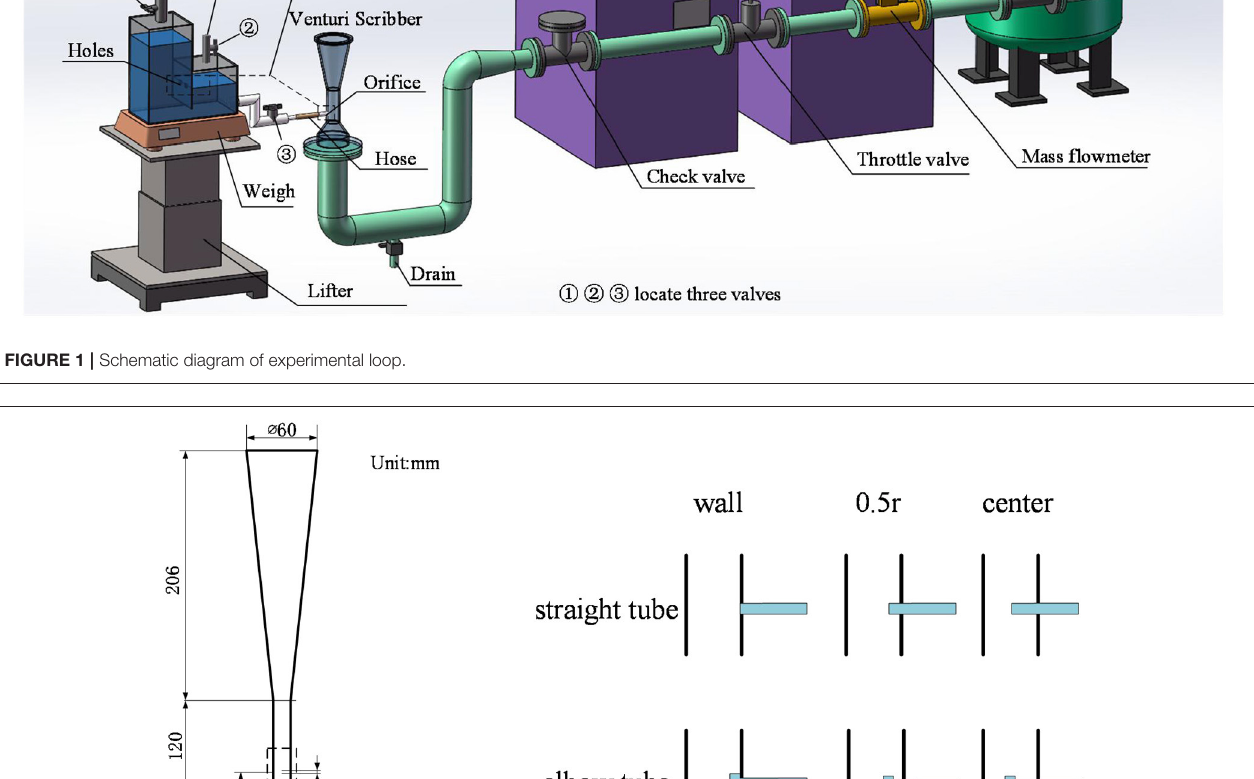
FIGURE 2 | Dimensions and nozzle arrangements of the Venturi